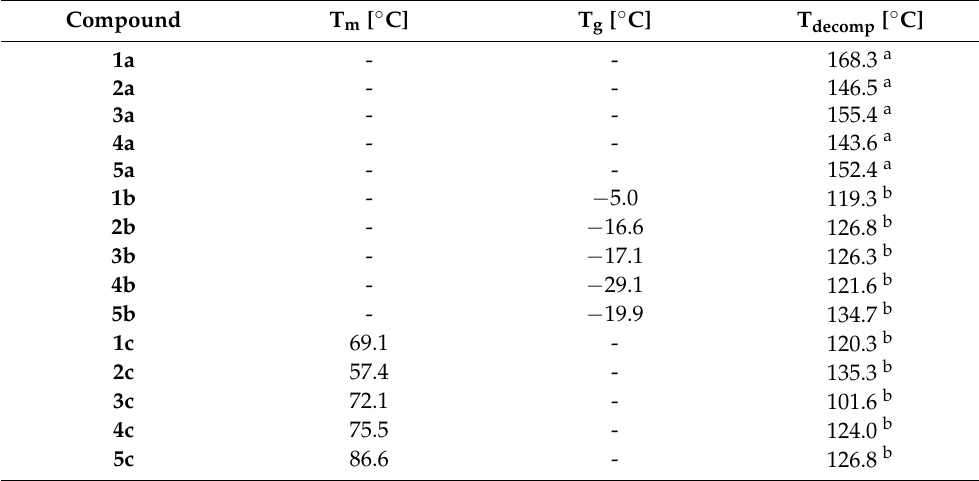
Table 2. Thermal properties of the HMTA-based compounds obtained in this